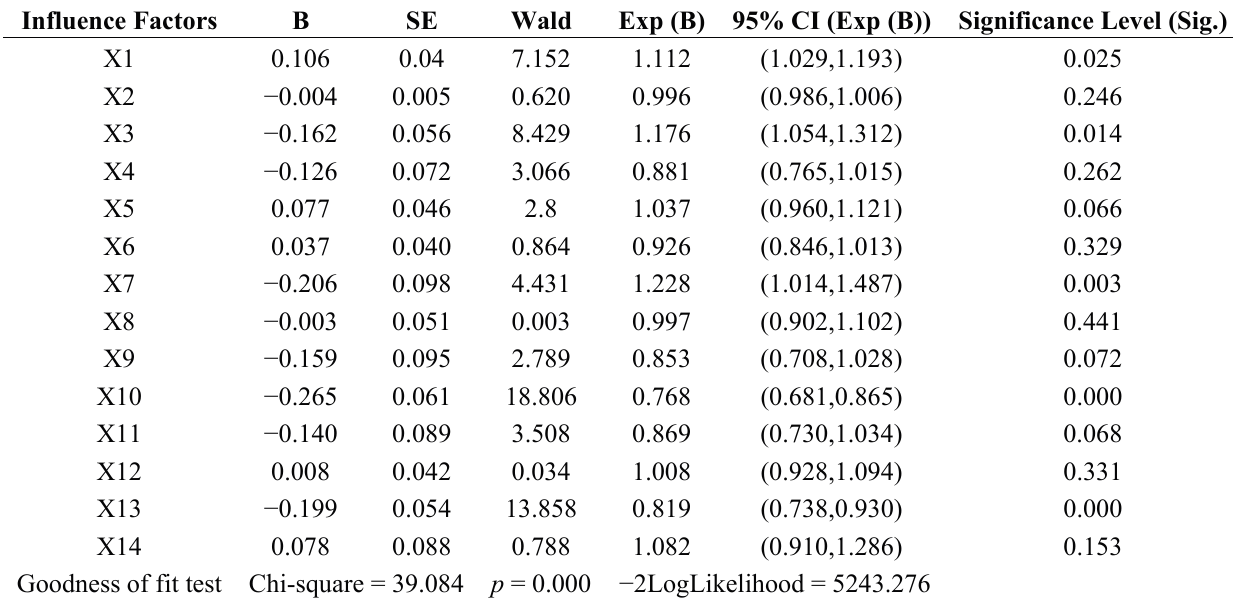
Table 5. COX proportional hazards model